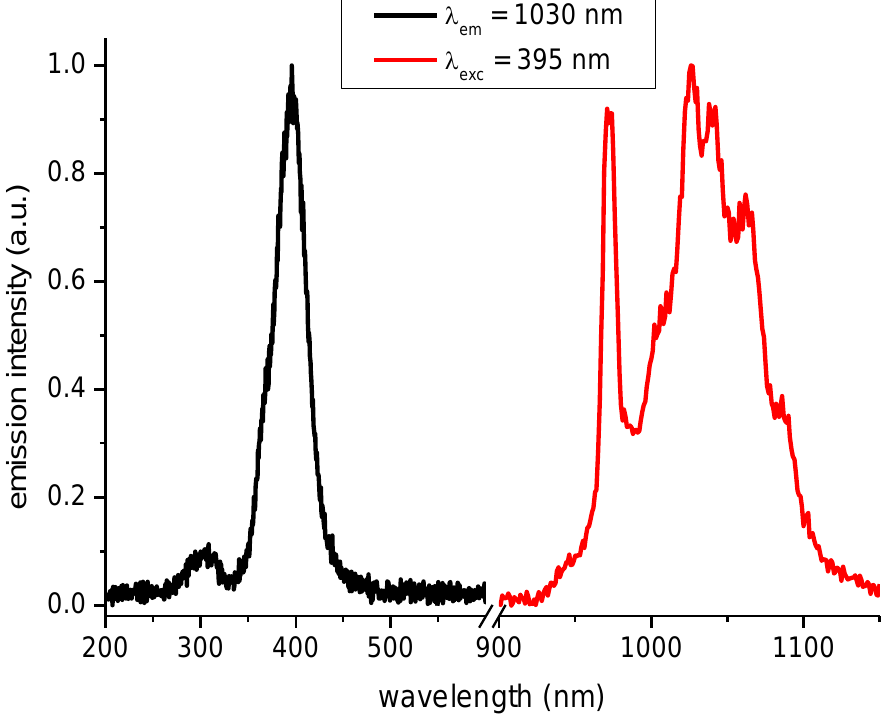
Figure 2. Emission spectrum of Yb 3+ after Ce 3+ excitation at 395 nm and excitation spectrum of Yb 3+ emission monitored at 1030 nm in YAM: 0.5% Ce 3+ + 1% Yb 3+